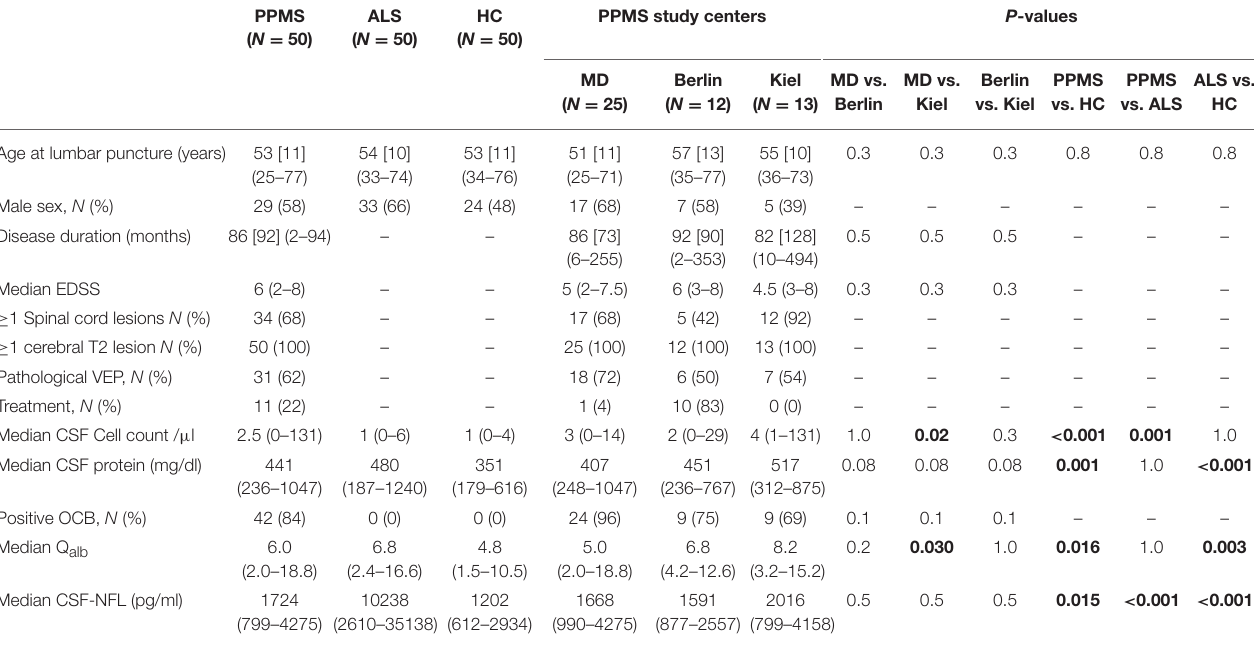
We investigated CSF-NFL levels in clinically definite PPMS patients suffering from a mainly long-standing disease without inflammatory disease activity. To our knowledge this is the largest cohort of patients investigated to date addressing the question